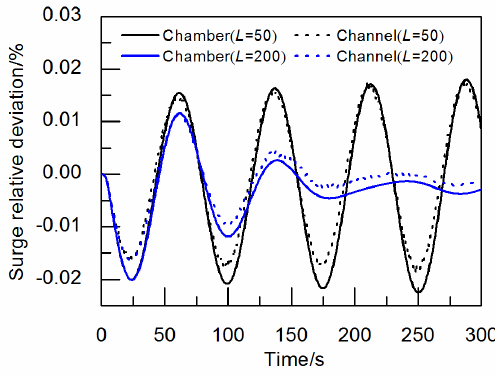
Figure 9. Comparison of surge waves at surge tank and at open channel